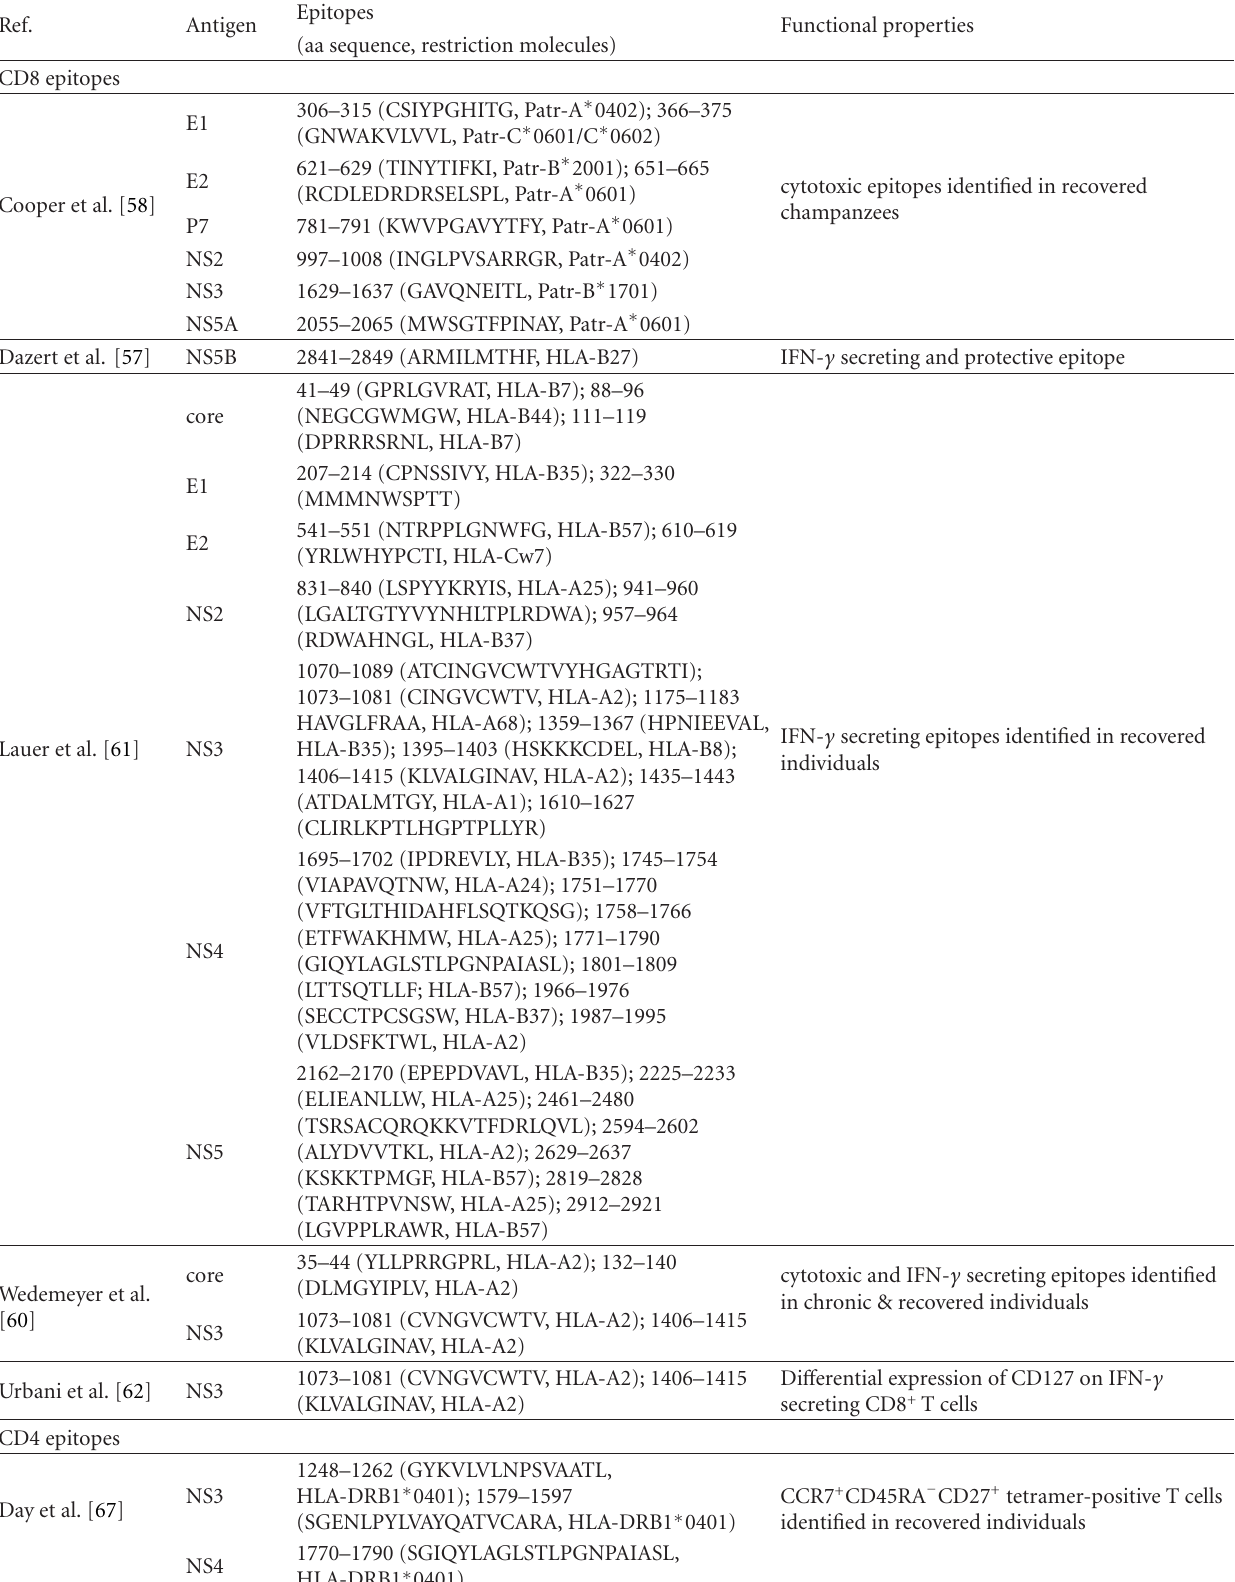
Table 2: Important epitopes of HCV recognized by T cells and B